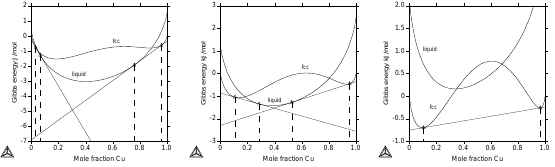
curves gives the most stable state. for the common